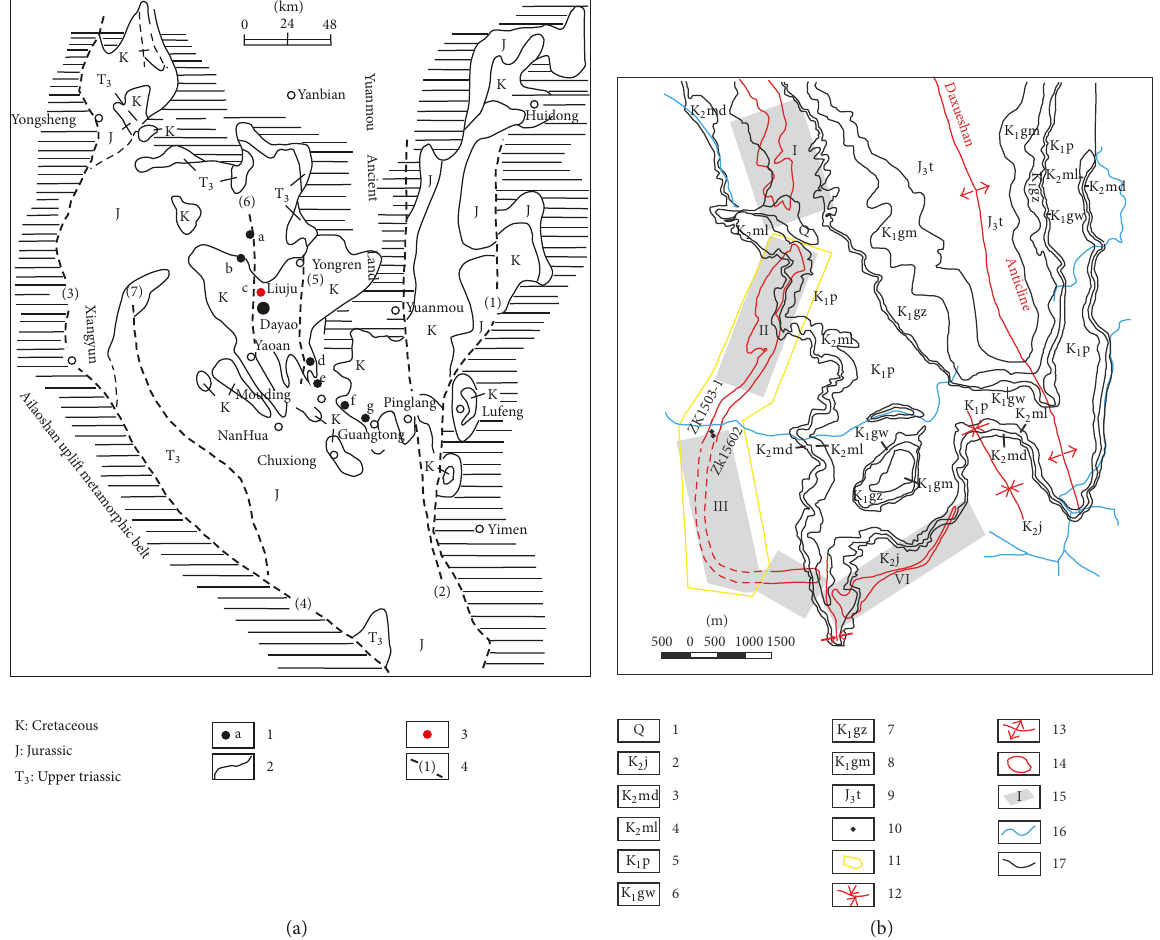
Figure 2: (a) Geological sketch of the Chuxiong basin; (b) Geology of the Dayao copper deposit (modified from measured geological